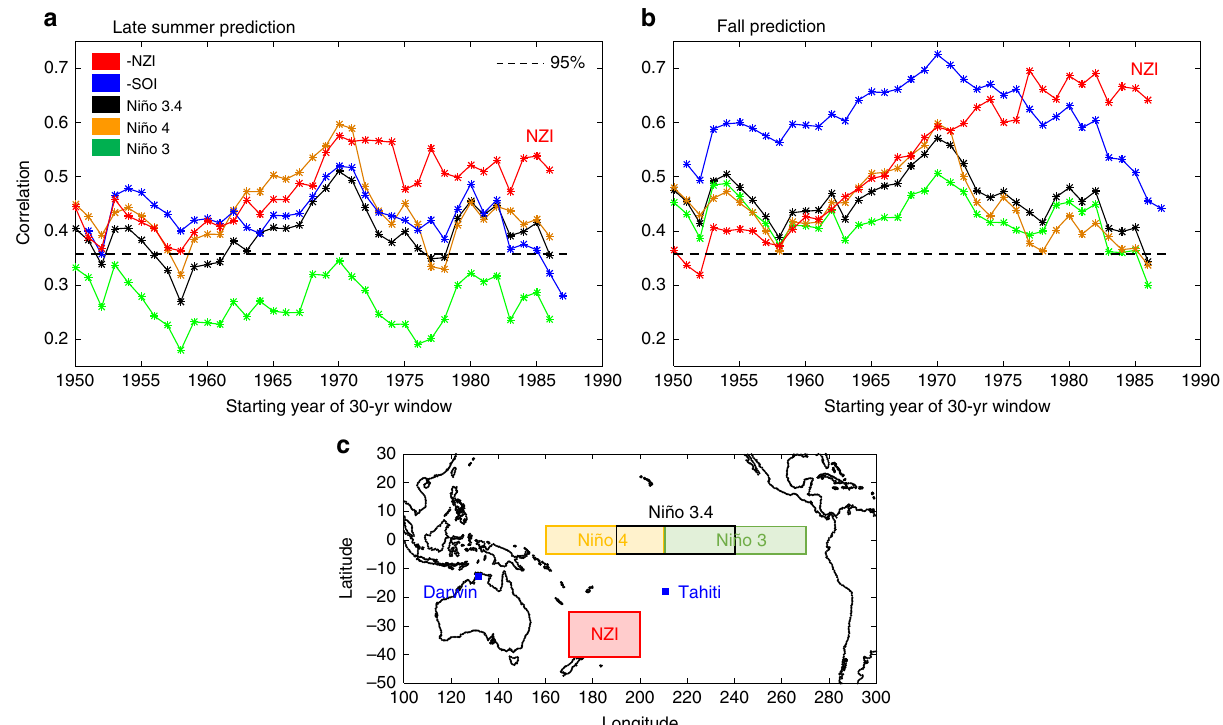
Fig. 2 Strengthening of NZI after the mid-1970s. 30-year running averages of ENSO and NZI teleconnection strengths for two different lead times: a Correlation values for 30-yr moving windows between different climate indices (averaged over Jul – Sep) and winter precipitation in SWUS (Nov-Mar); b same as ( a ) but when climate indices are averaged over Sep – Nov. Dashed lines indicate the threshold below which correlations are statistically insigni fi cant ( α = 0.05 signi fi cance level); c the location and areal extent of NZI and ENSO indices. SOI (Southern Oscillation Index 14 ) is de fi ned as the standardized difference of the sea level pressure anomalies at Tahiti and Darwin